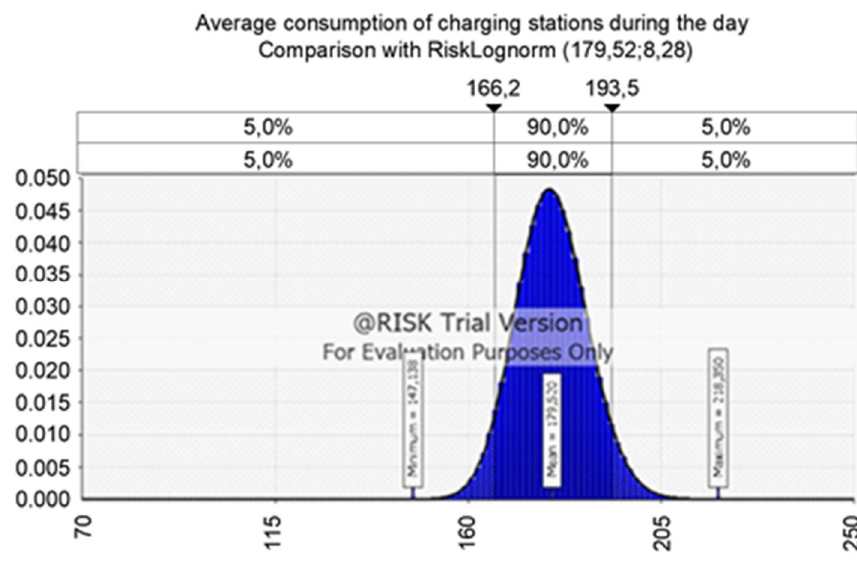
Figure 18. Simulated consumption of charging stations overnight.